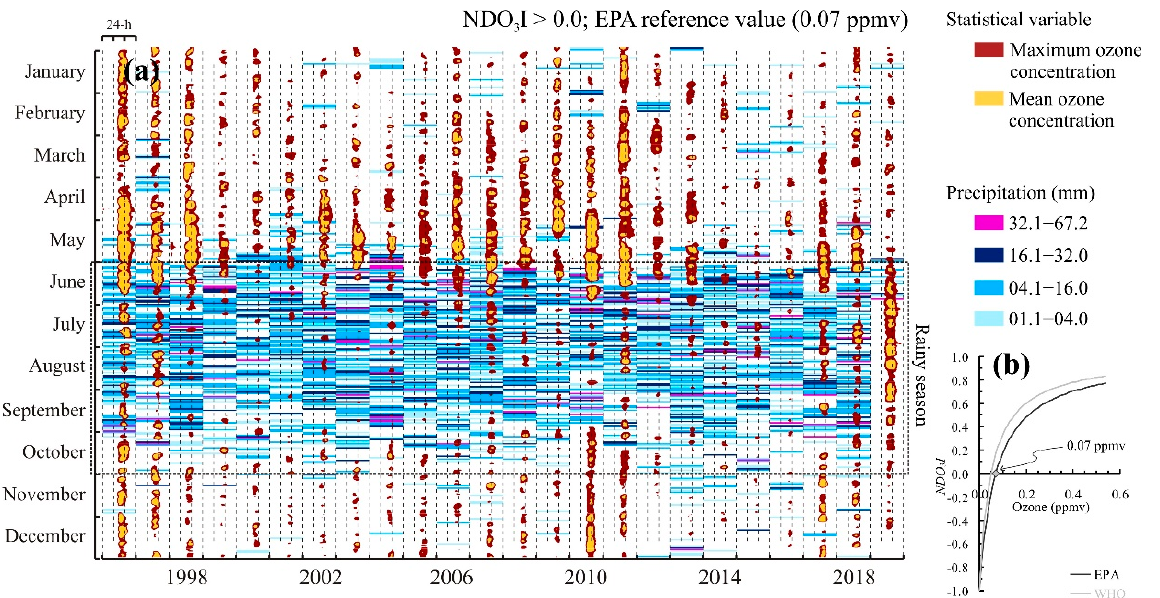
Figure 6. (a) Ozone measurements above the EPA’s standard limit, derived from the ozone index (NDO 3 I) analysis of the twenty-four-years of the time-series sequence of the Guadalajara Metropolitan Area. (b) Graphical representation of the NDO 3 I referred to the EPA’s limit.